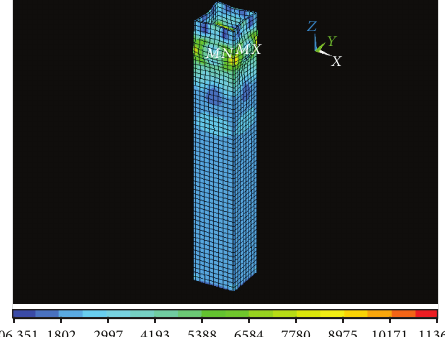
Figure 22: Typical computed deformed shapes of